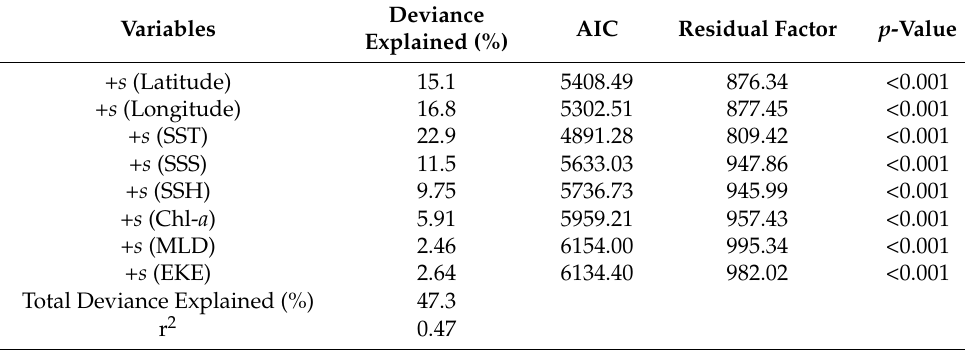
Table 3. The contribution of observed catch rates and environmental variables added progressively (first to last) that were retained in the fitted GAMs and determined using the residual factor. DE by the model represented the goodness-of-fit of the model; an approximate AIC value was employed to identify the optimal model. The model’s prediction ability was measured by the determination coefficient (r 2 ) for S. dumerili catch rates in the TS (all p <